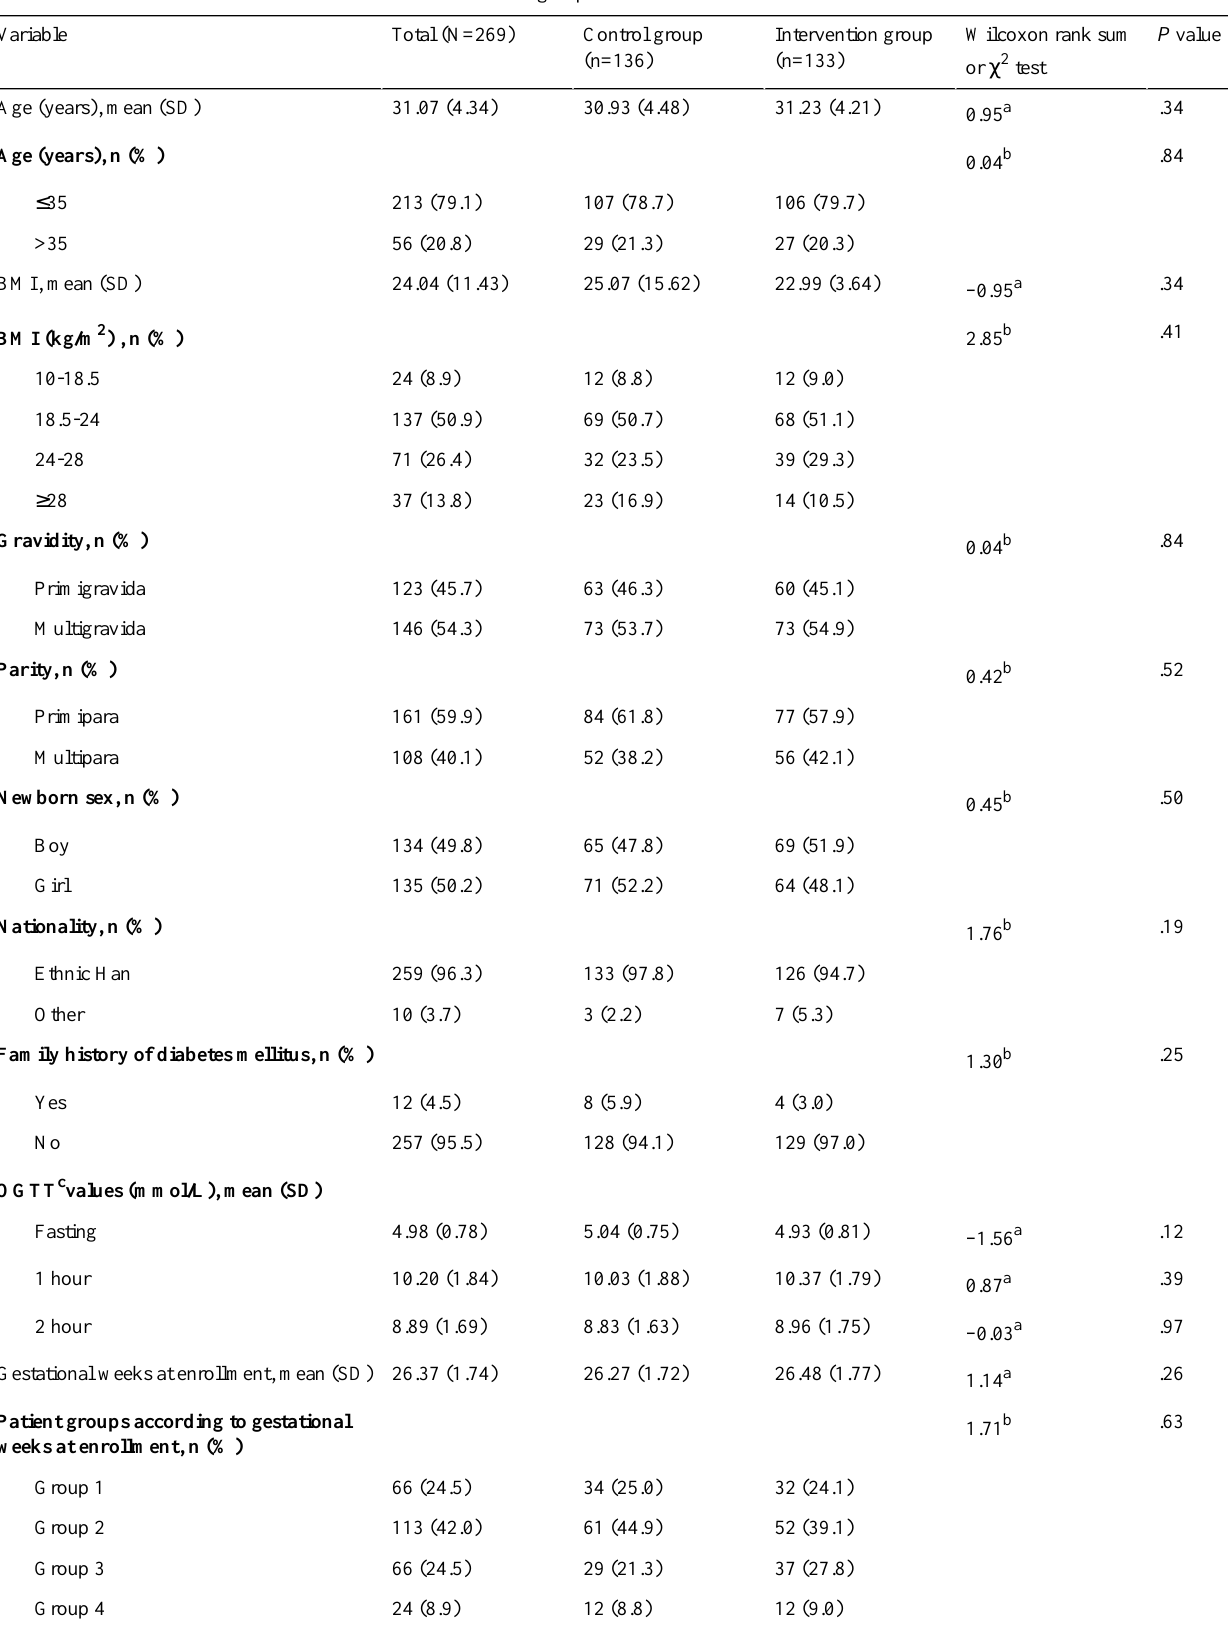
Table 1. Baseline characteristics of the intervention and control